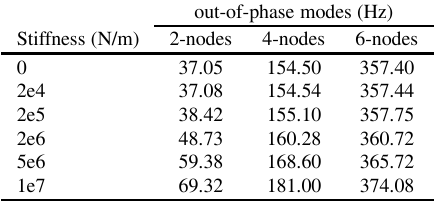
Table 2 Variation of natural frequencies to the connecting